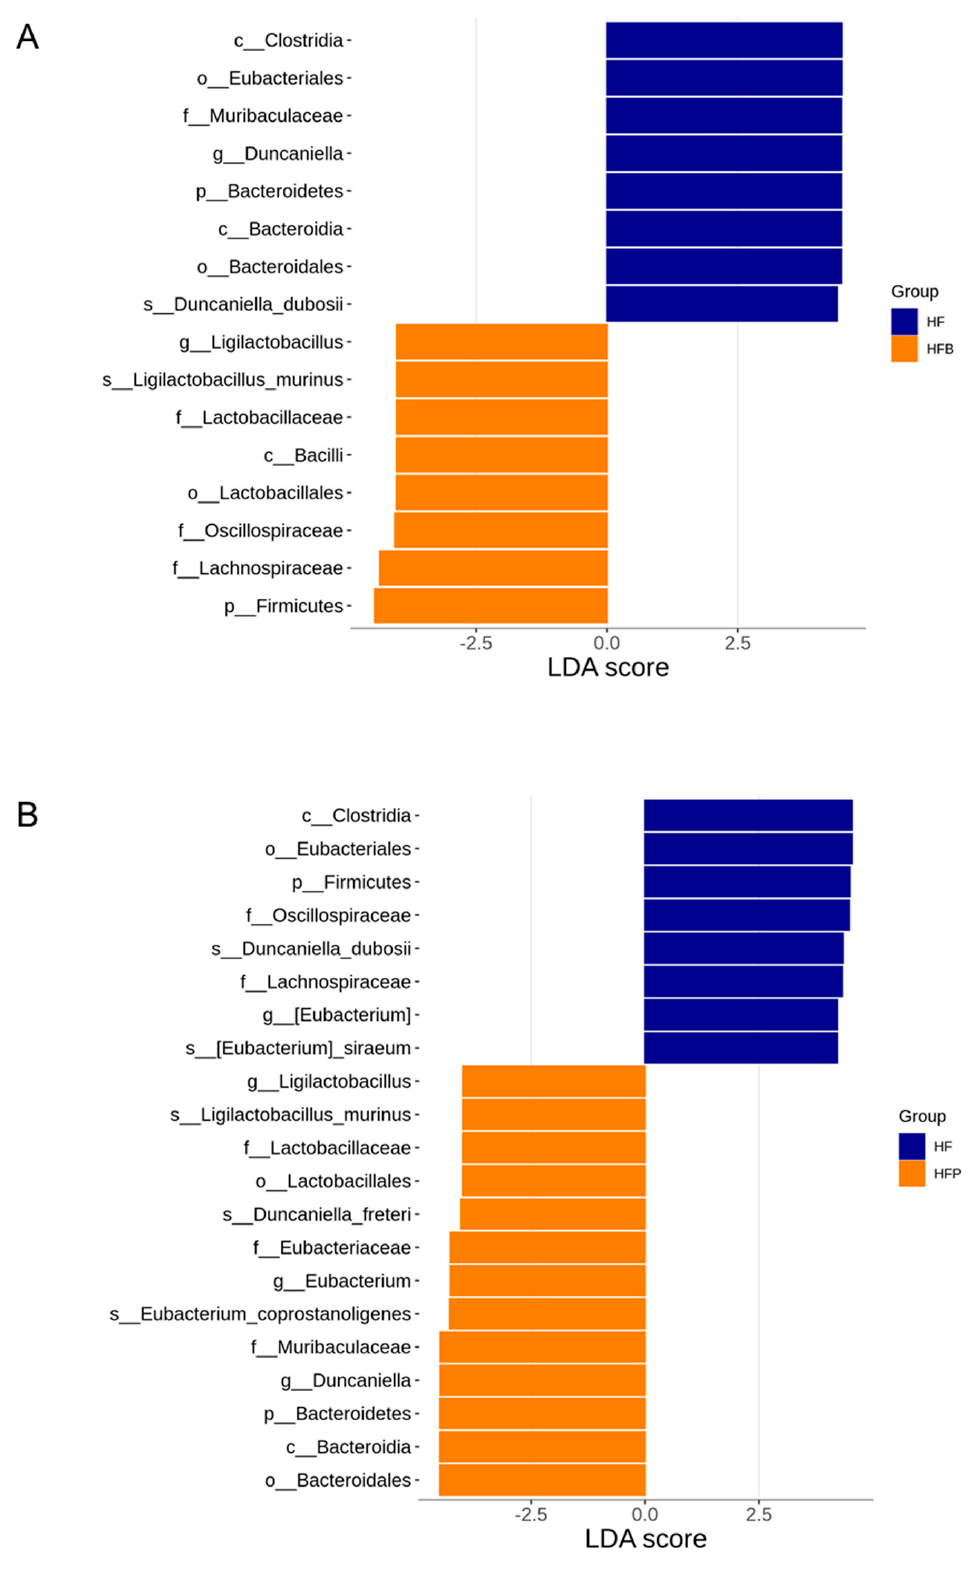
Figure 7. Linear discriminant analysis effect size (LEfSe) identified the most differentially abundant taxa between ( A ) the HF and HFB group and ( B ) the HF and HFP group. The threshold of the linear discriminant analysis score was set at 4.